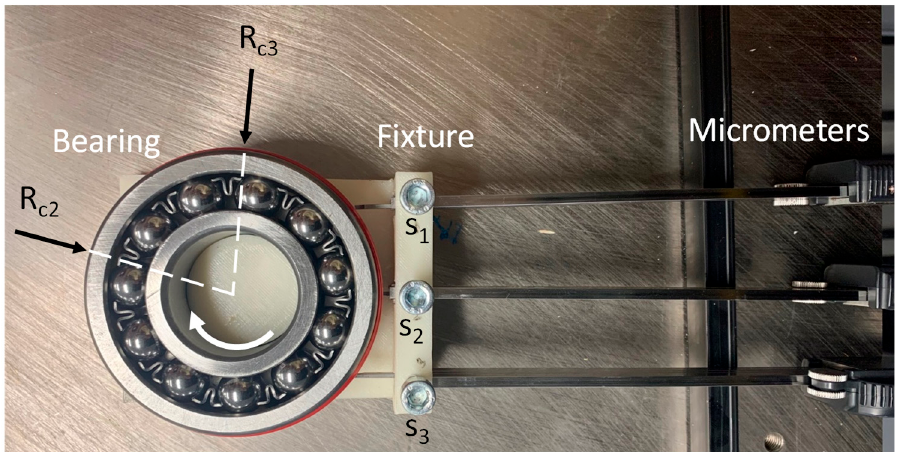
Figure 12. Apparatus for system calibration and characterization. Table 9. Displacements of the calibration master measured at two radii by using displacement sensors with ±0.01 mm accuracy.